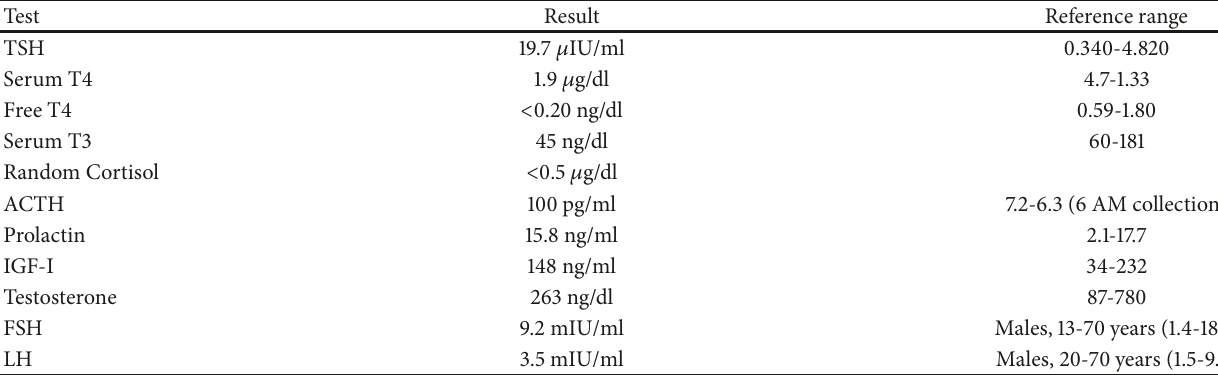
Table 1: Laboratory